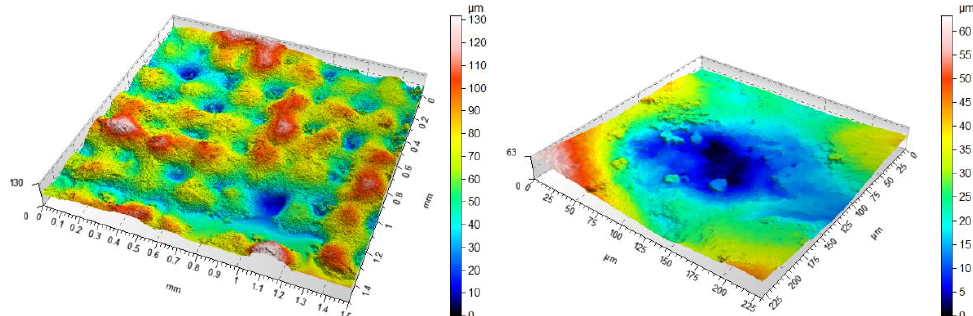
Figure 7. Example isometric view of the surface of sample 6 with a view of an example dimple at 90°; scales should be analysed carefully.